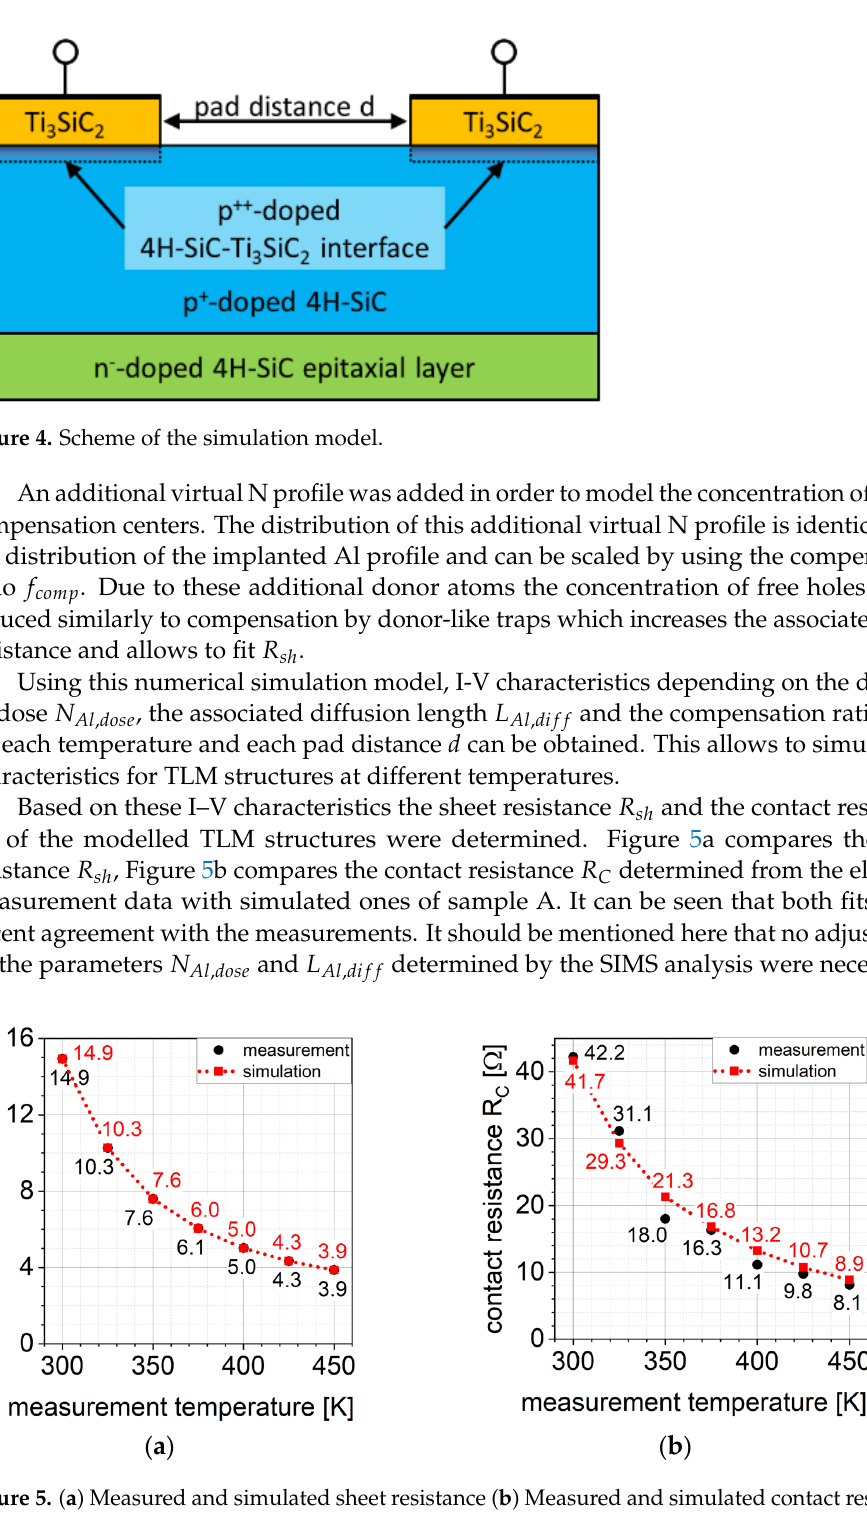
Figure 6. Temperature dependence of determined compensation ratio. 4. Discussion Due to the well-fitted simulation results, it can be concluded that the numerical sim- ulation model is suitable to describe Ti 3 SiC 2 based ohmic contacts on p-doped 4H-SiC tem- perature dependent. Considering the fact that the simulation model does not show ohmic behavior when not using the surface near Al profile it can be further concluded that the surface near Al profile is essential for the ohmic contact formation. Based on these results it is possible to propose a theory regarding the formation mechanism of Ti/Al based ohmic contact on p-doped 4H-SiC and the role of Ti 3 SiC 2 during contact formation. During the Ti 3 SiC 2 formation a certain amount of Al diffuses in the SiC surface via lattice places and increases the surface near Al concentration significantly. This increase of the surface near Al concentration can significantly decrease the specific resistance 𝜌𝜌 𝐶𝐶 (see Equation (10)) and is therefore the key in the ohmic contact formation.